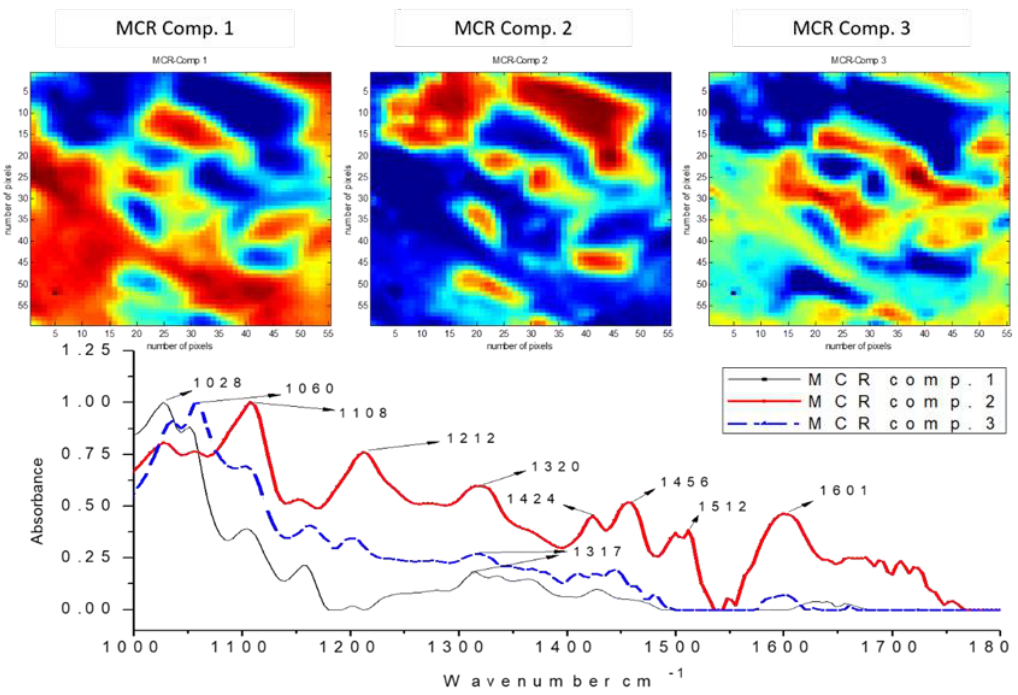
Figure 8. MCR−ALS relative concentration and recovered spectra of chemical components of Figure 8. MCR − ALS relative concentration and recovered spectra of chemical components of pre − treated materials pre−treated materials obtained by steam explosion. FT−IR micro-image of E. globulus pre-treated at obtained by steam explosion. FT − IR micro-image of E. globulus pre-treated at severity S 0 severity S 0 12.31.